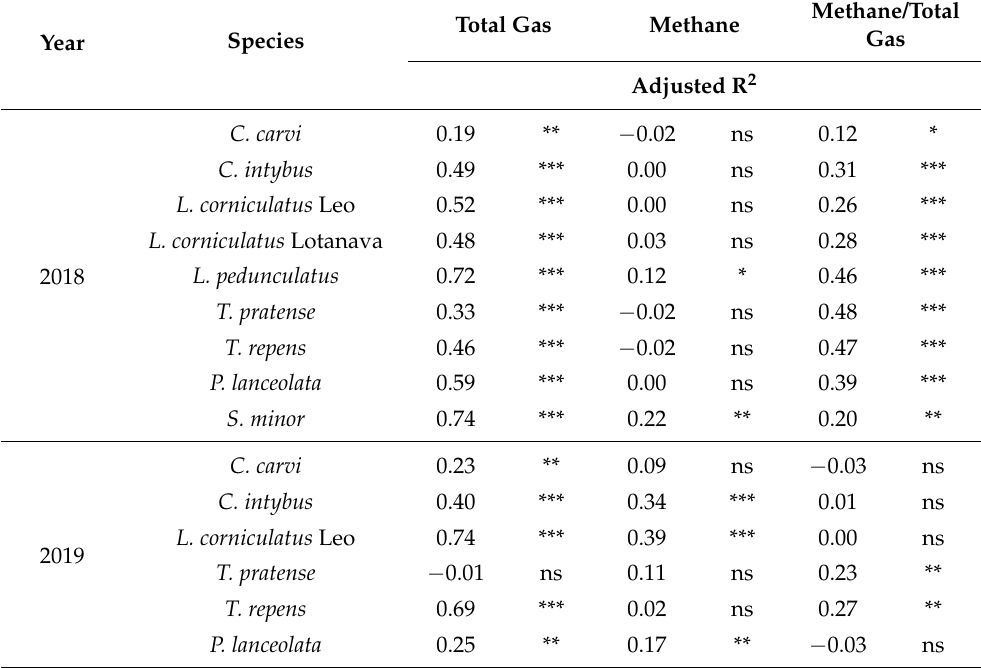
Table 6. Mean adjusted R 2 and p values derived from basic linear regression for methane production (mL/200 mg DOM), total gas production (mL/200 mg DOM) and methane concentration after 24 h-rumen fermentation of the studied forage species harvested in 2018 and 2019.